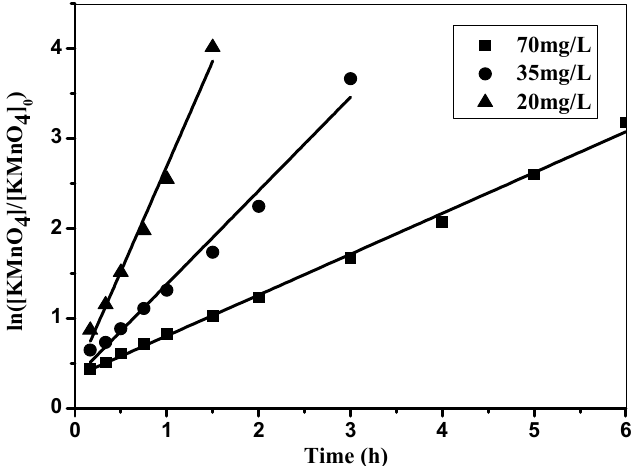
decomposition for different concentrations of KMnO 4